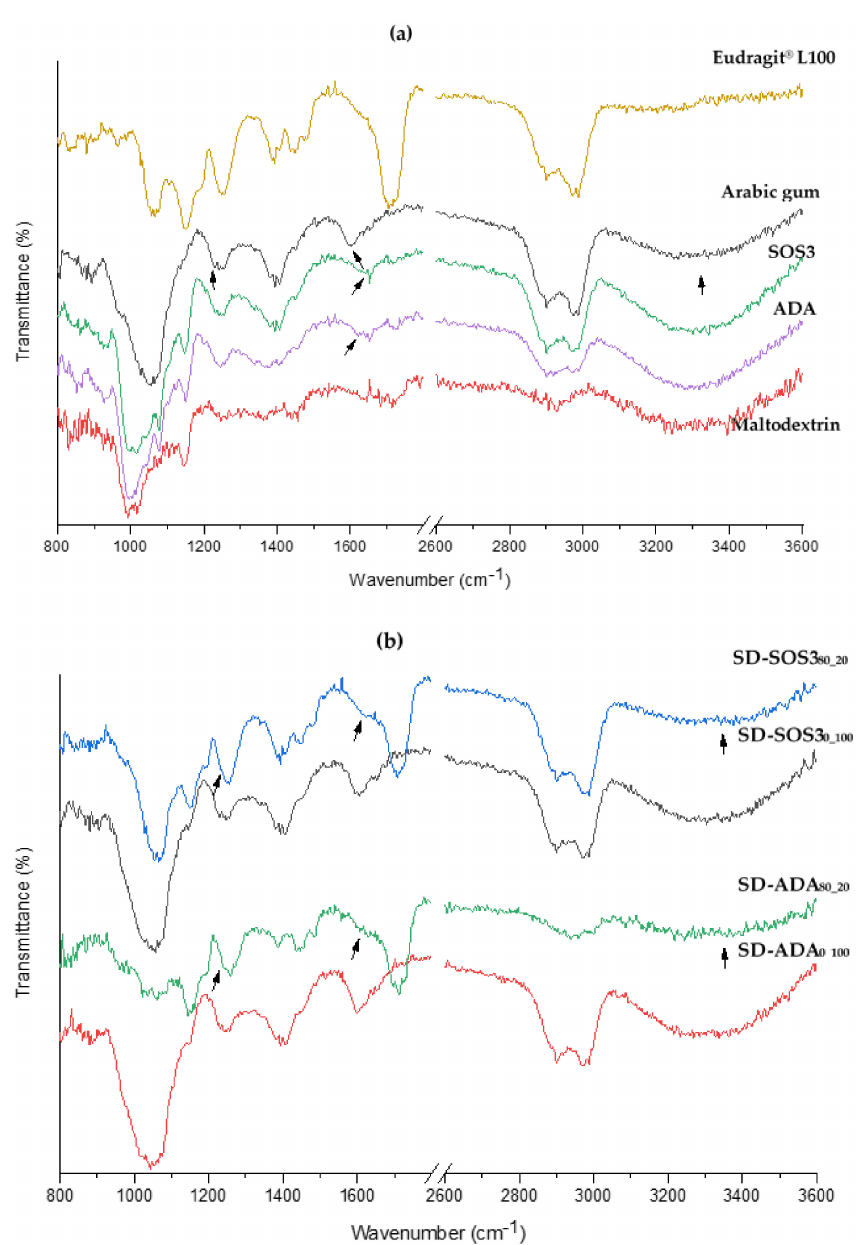
Figure 9. FTIR spectra of encapsulating wall materials ( a ) and spray-dried products ( b ) prepared from emulsions stabilized with polysaccharides only (subscript 0_100 ) or polymer / polysaccharides 80 / 20 (subscript 80_20 ) with modified starches ADA (SD-ADA 0_100 , SD-ADA 80_20 ) and SOS3 (SD-SOS3 0-100 , SD-SOS3 80_20